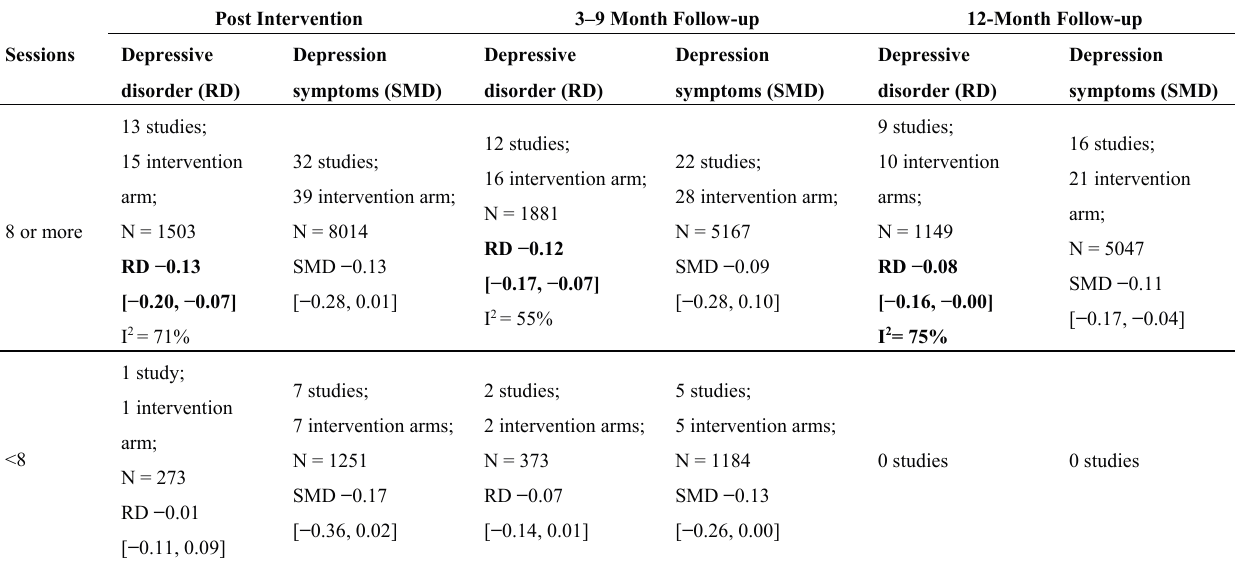
Table 6. Summary of meta-analysis results for approach to prevention programs analysed by number of sessions